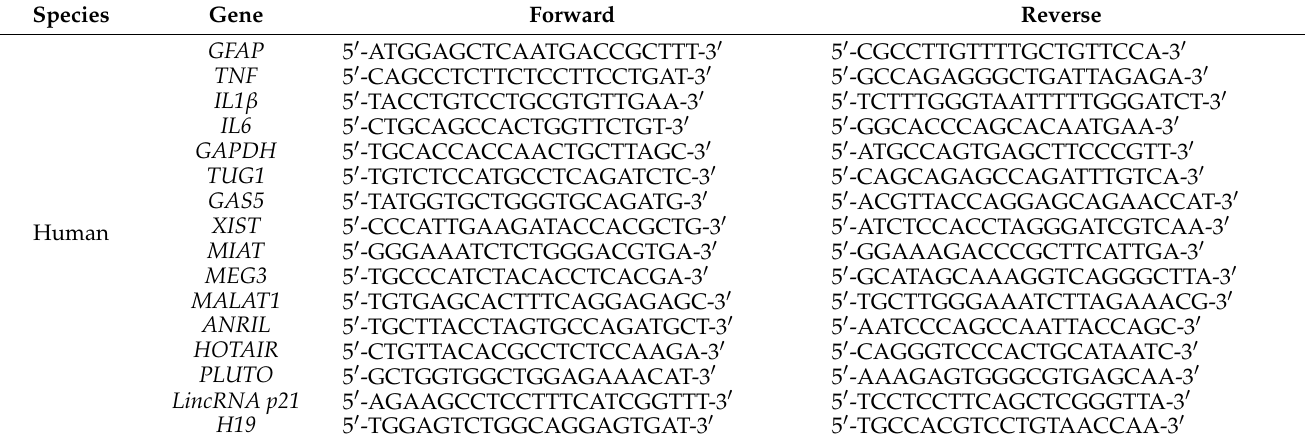
Table 1. List of primers used in this